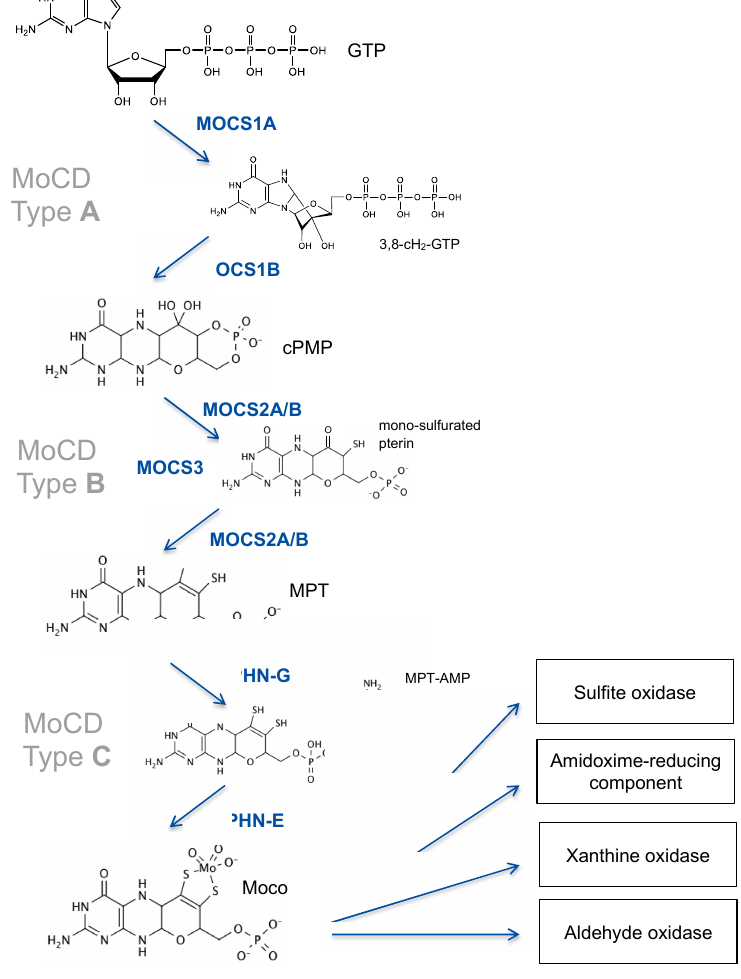
Figure 1. Moco biosynthesis; Mo-enzymes and deficiencies. Intermediates of Moco synthesis are 3 ′ 8-cyclo 7,8-dihydro-GTP, cyclic pyranopterin monophosphate (cPMP), mono-sulfurate pterin, metal binding pterin (MPT), and adenylated MPT (MPT-AMP). Proteins and domains (GPHN) in-